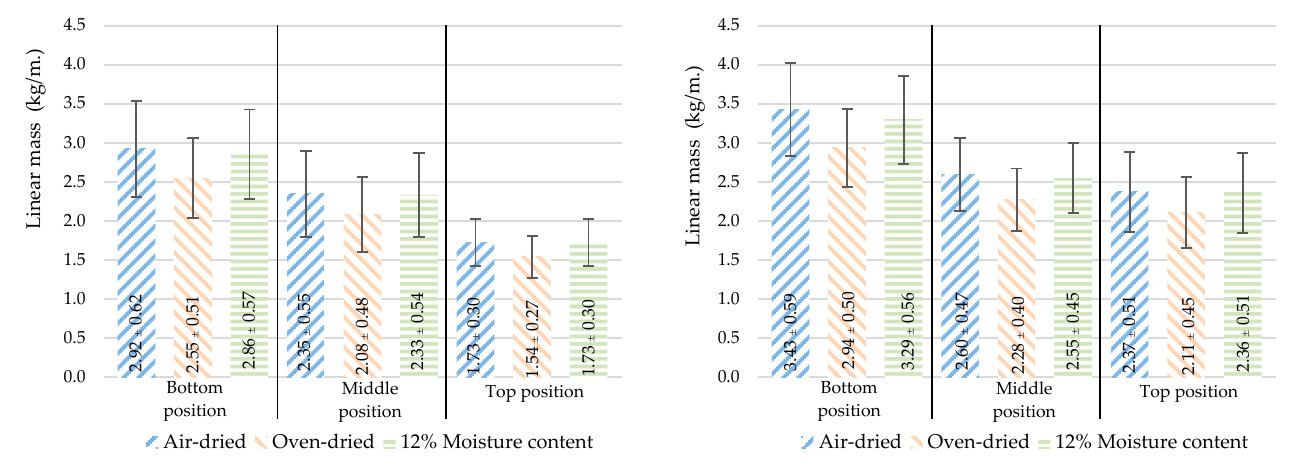
Figure 8. The linear mass varied with moisture contents and positions: ( a ) internode, ( b ) node (mean ± standard deviation).